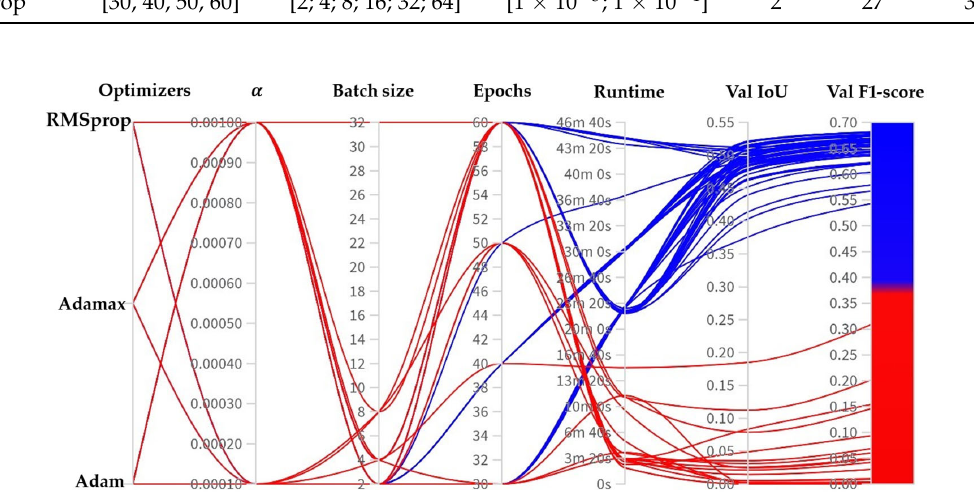
Figure 6. Parallel coordinate plots of hyperparameter optimization experiments.